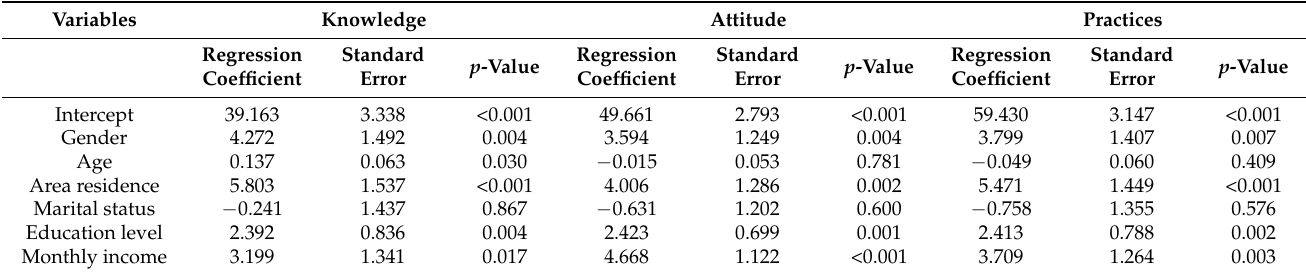
Table 5. Linear regression models for knowledge, attitude, and practice domain ( N = 573).